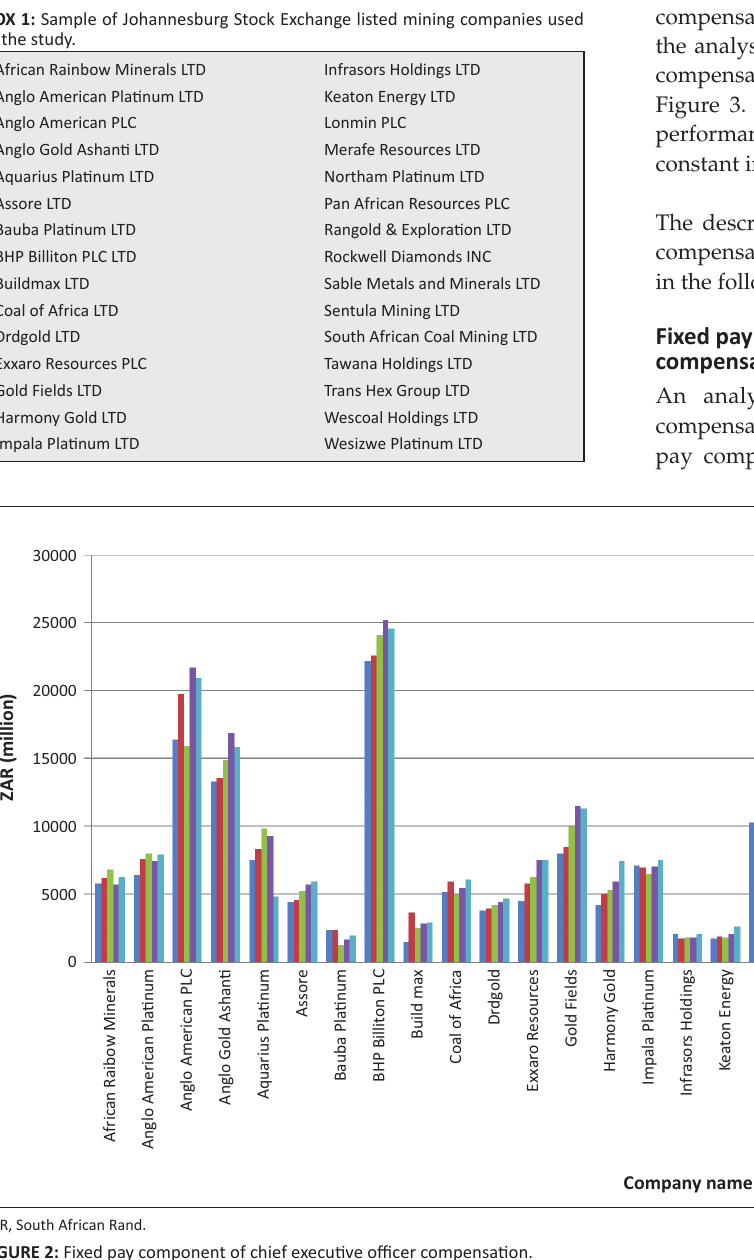
FIGURE 2: Fixed pay component of chief executive officer compensation.